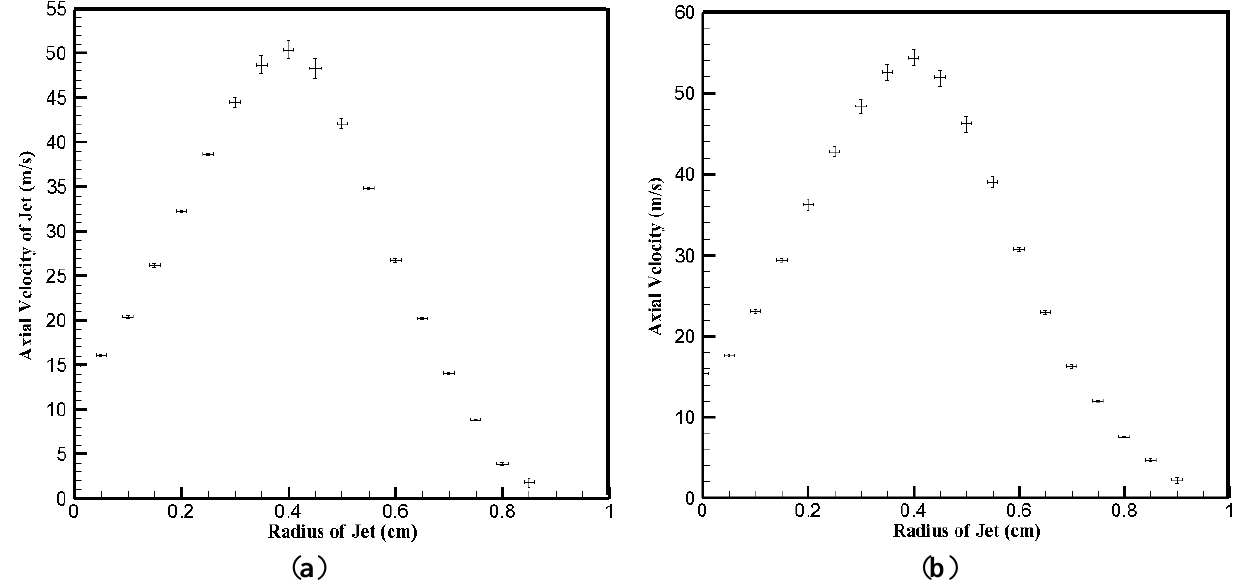
Figure 4. Axial velocity vs. radius for ( a ) Experiment 1 at z = 2.5 cm; ( b ) Experiment 2 at z = 2.5 cm; ( c ) Experiment 3 at z = 2.5